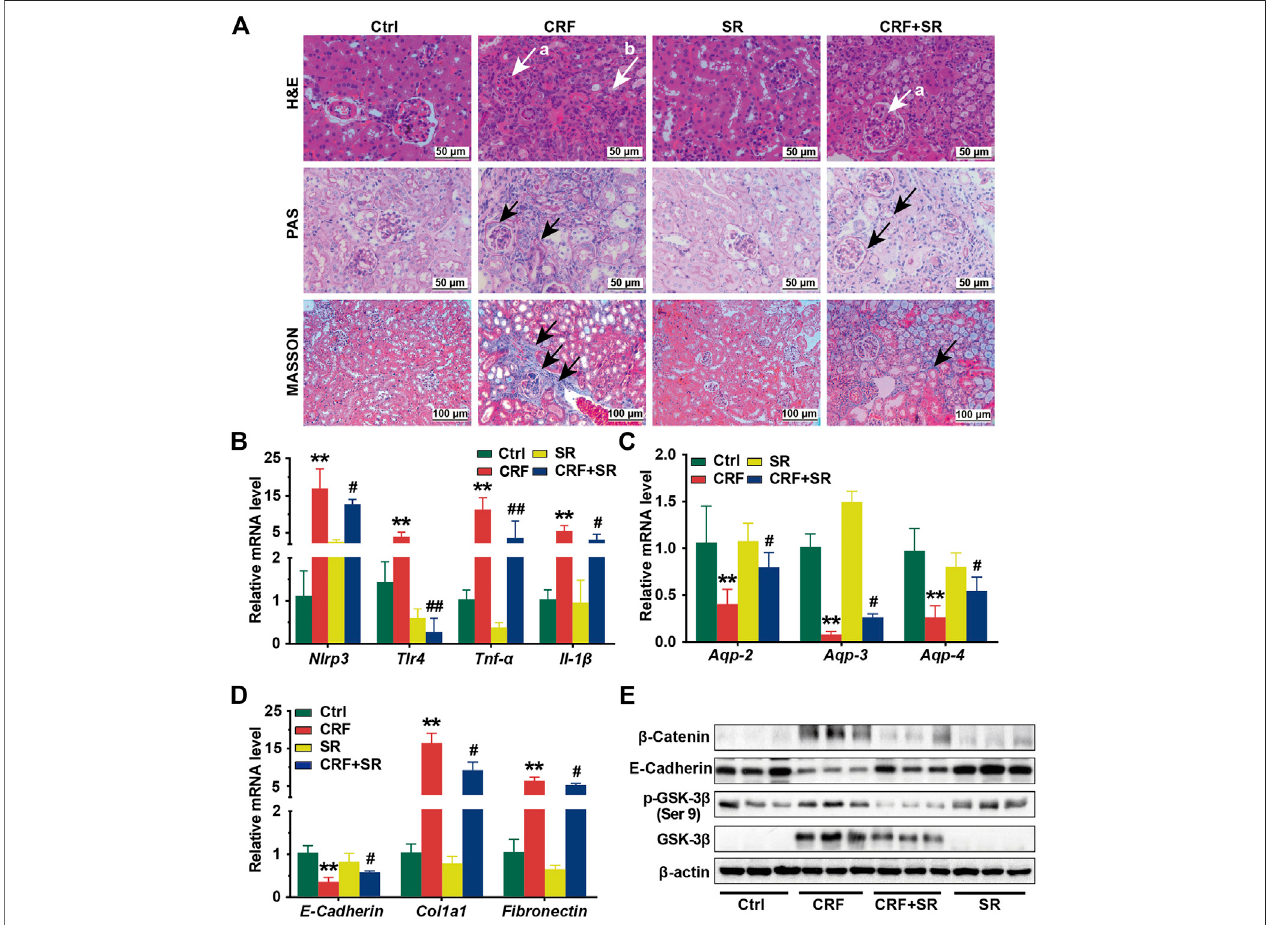
FIGURE3| Reversalofin fl ammatoryresponses, fi brosis,reducedaquaporinsinkidneytissuesofCRFmicebySRdecoction. (A) Morphologicalchangesofkidney tissuesamongfourexperimentalgroupsbyH&Estaining(400×, “ a ” indicatesglomerulosclerosisand “ b ” indicatestubularatrophy),PASstaining(400×,arrowsindicate lesions), and MASSON staining (200 ×, arrows indicate collagen fi ber). (B) Expressions of proin fl ammatory cytokines, including Nlrp3 , Tlr-4 , Tnf- α , and Il-1 β at mRNA levels. (C) Expressions of aquaporins, including Aqp-2 , Aqp-3 , and Aqp-4 at mRNA levels. (D) Expressions of renal fi brosis-related molecules, including E-Cadherin , Col1a1 , and Fibronectin at mRNA levels. (E) Expressions of renal fi brosis signaling pathway-related regulators, including β -Catenin, E-Cadherin, p-GSK-3 β (ser 9), and GSK-3 β at protein levels by Western blot. Data were presented as mean ± SD. * p < 0.05, ** p < 0.01 vs. Ctrl group; # p < 0.05, ## p < 0.01 vs. CRF group.